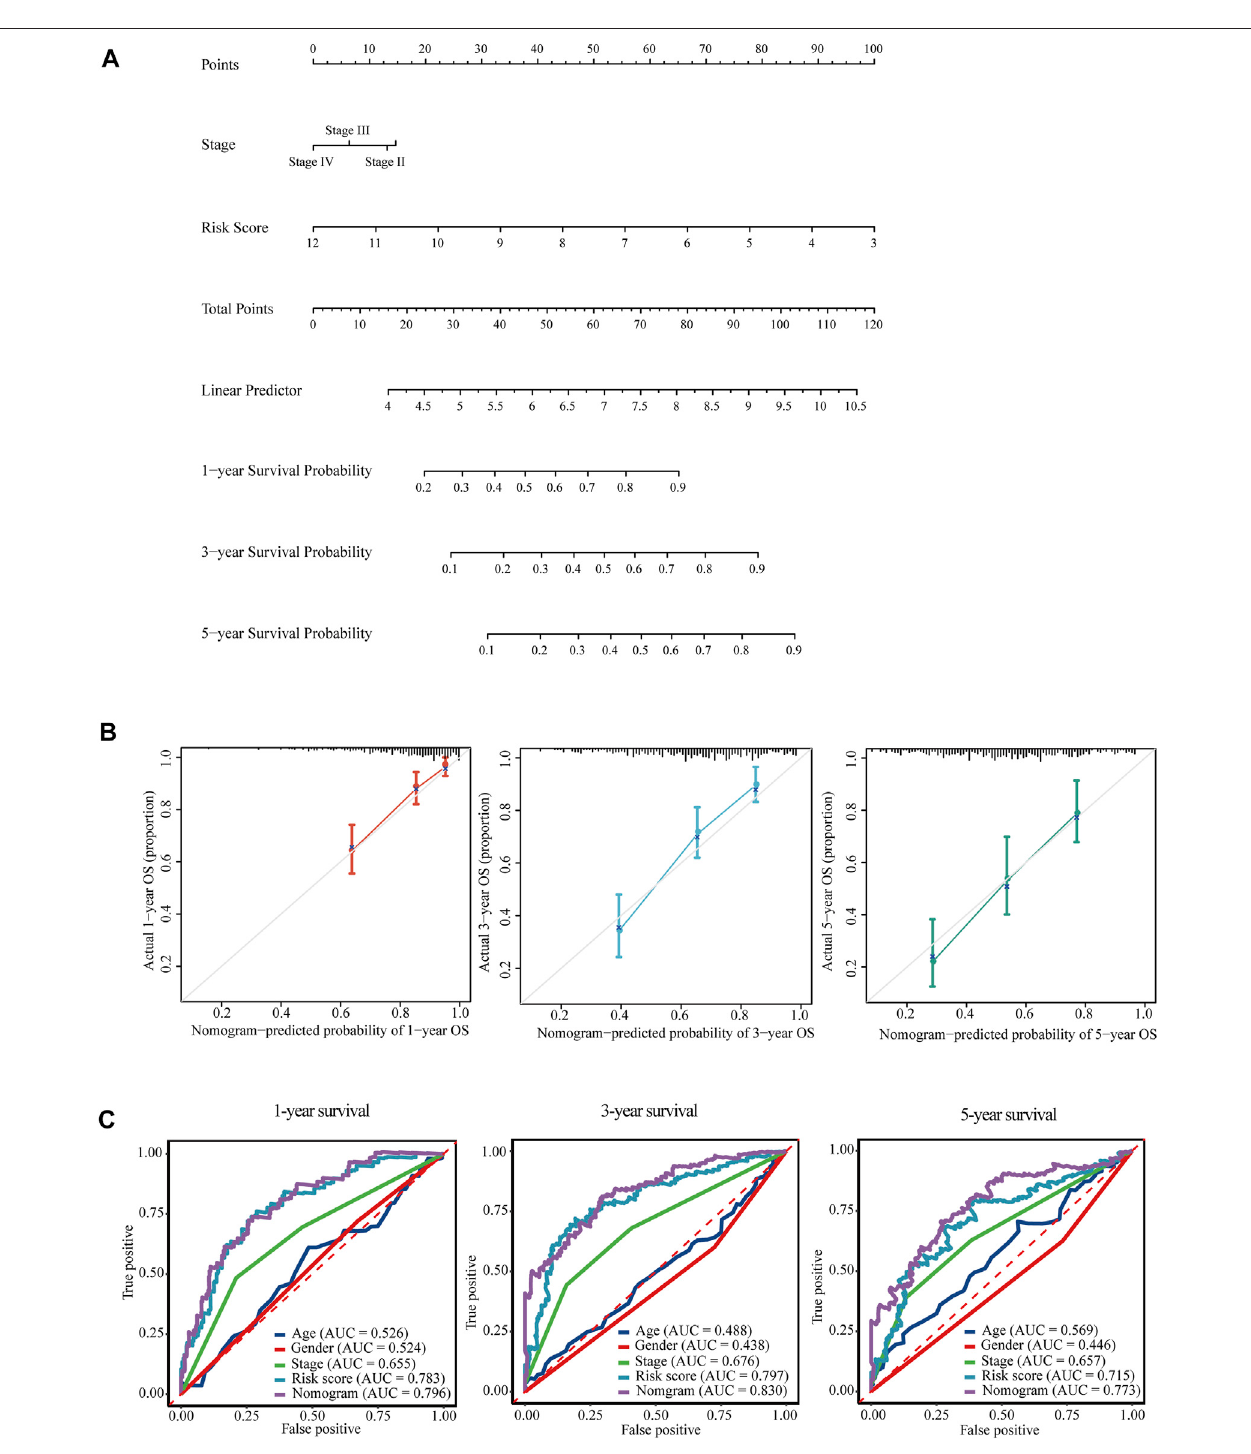
FIGURE 8 | Nomogram for the prediction of overall survival of HCC in TCGA-LIHC. (A) A prognostic nomogram for predicting the probabilities of 1-year, 3-years, and 5-years overall survival of HCC patients in TCGA-LIHC. (B) Calibration plots for evaluation of the predictive performance of the constructed nomogram. (C) Time- dependent ROC curves displayed the comparisons of AUCs among diverse prognostic models.